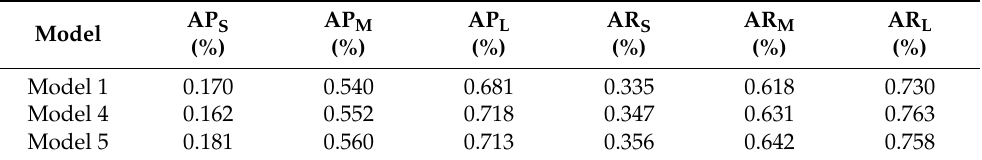
Table 6. Validation results for the improvement of small and medium target recognition capability.